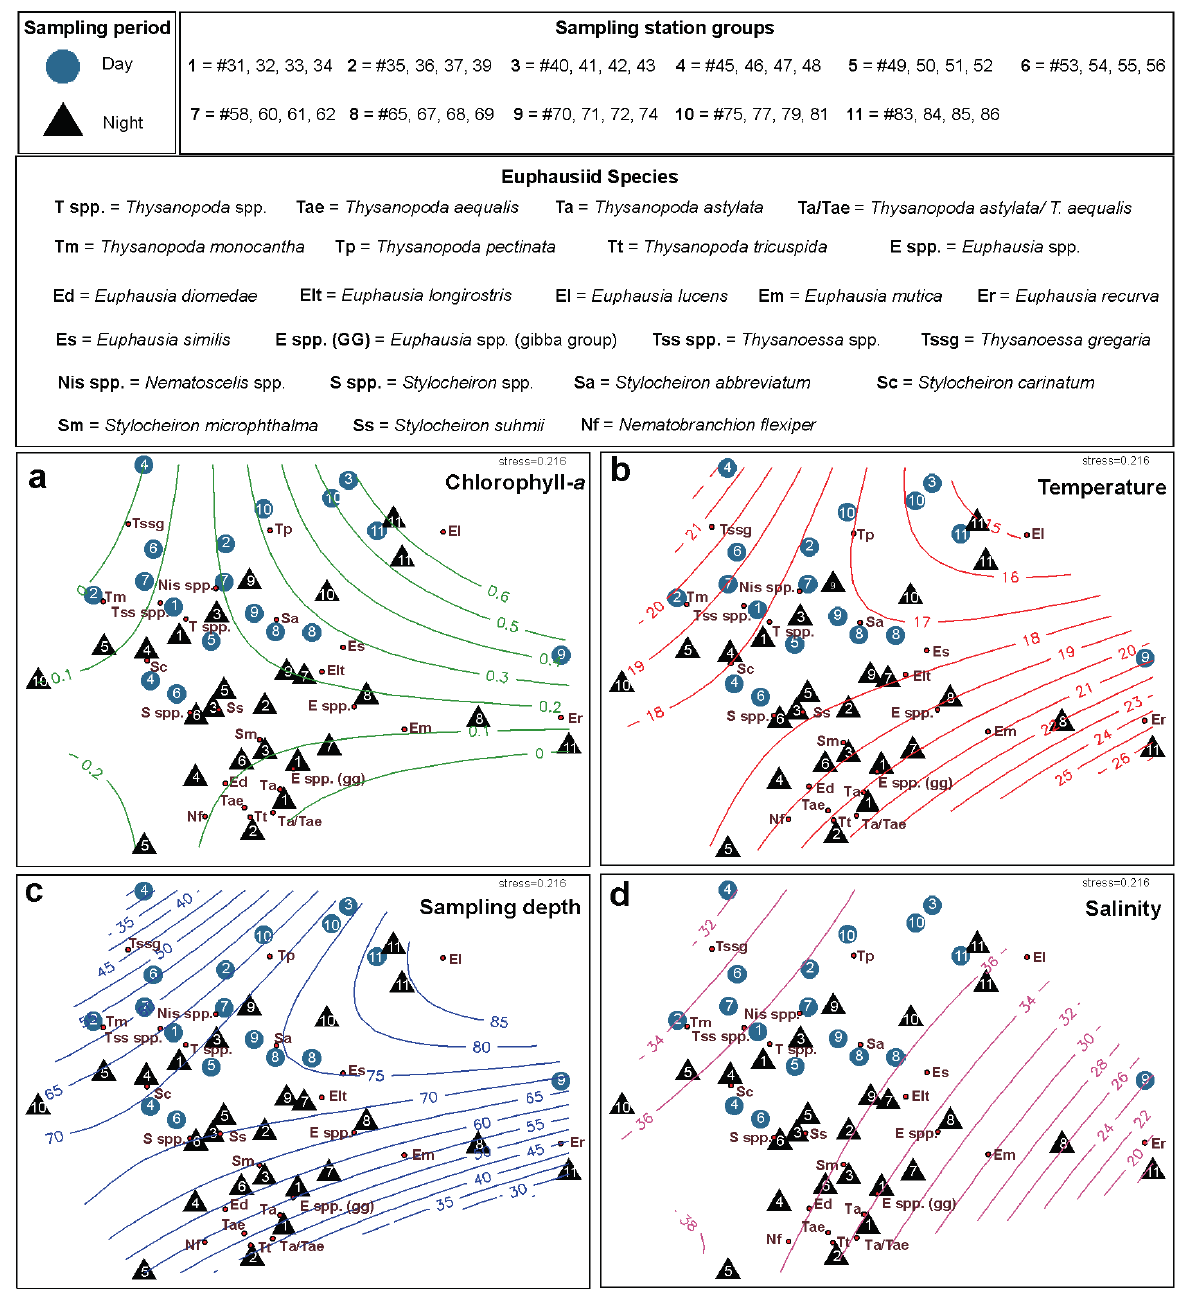
Figure 3 - MDS ordination based on Bray-Curtis similarity and euphausiid species composition (44 samples) from a Brazil-Africa cruise and different environmental variables: ( a ) chlorophyll- a ; ( b ) temperature; ( c ) sampling depth; ( d )